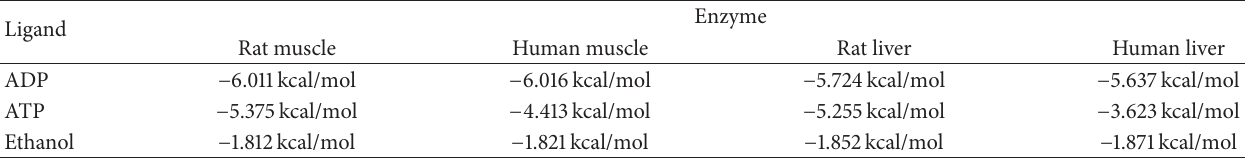
Figure 4: A circle dendrogram representing phylogenetic relations between muscle, liver, and platelet phosphofructokinases of vertebrates. Homologous protein of the lancelet is used as an outgroup. Phylogenetic tree is built by UPGMA method based on the JTT amino acid evolutionary distances. Table 3: Average free energies of binding for ADP, ATP, and ethanol with human and rat muscle and liver phosphofructokinases.